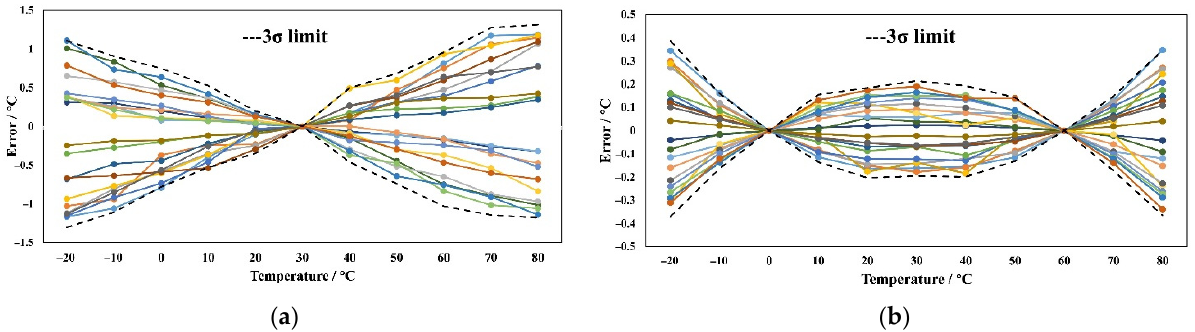
Figure 18. Measured linearity of 20 test chips for ( a ) one-point calibration at 30 °C; ( b ) two-point calibration at 0 °C and 60 °C .